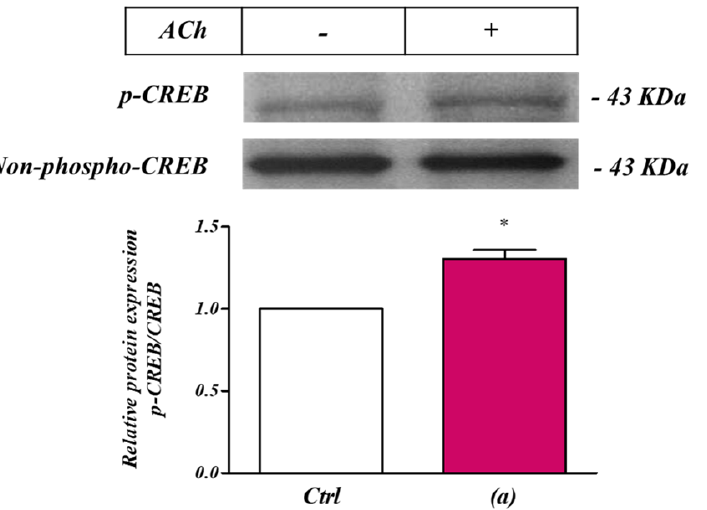
Figure 7. ACh ‘priming’ enhanced CREB activation in SH − SY5Y human neuroblastoma cells. West- ern blot analysis of the ACh priming effect on CREB expression level in SH − SY5Y neuroblastoma cells. 5 min pre-stimulation with ACh (ACh, 1 µM) induced a significant enhancement of CREB phosphorylation ( a ). * p < 0.05 vs. Ctrl. One − way analysis of variance, followed by Multiple Com- parison test with Bonferroni’s correction. ( n = 6).